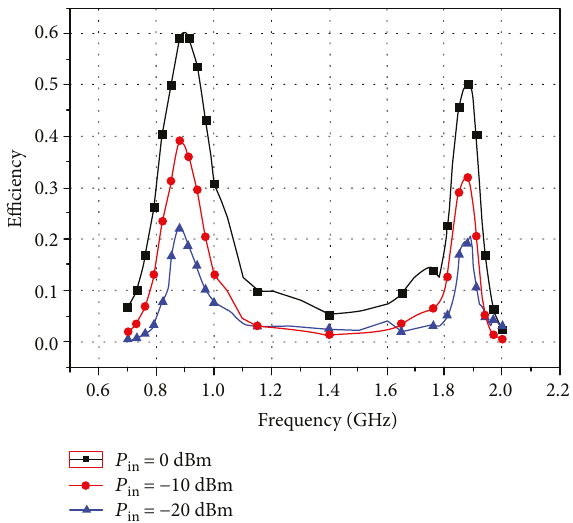
Figure 13: Measured RF-dc e ffi ciency versus frequency.